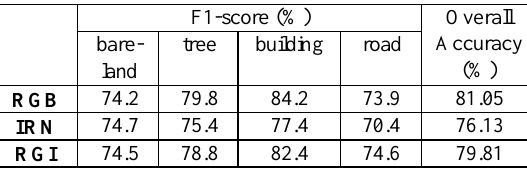
Table 1. Comparison of the overall accuracy and F1-score per-classes of different feature combinations.